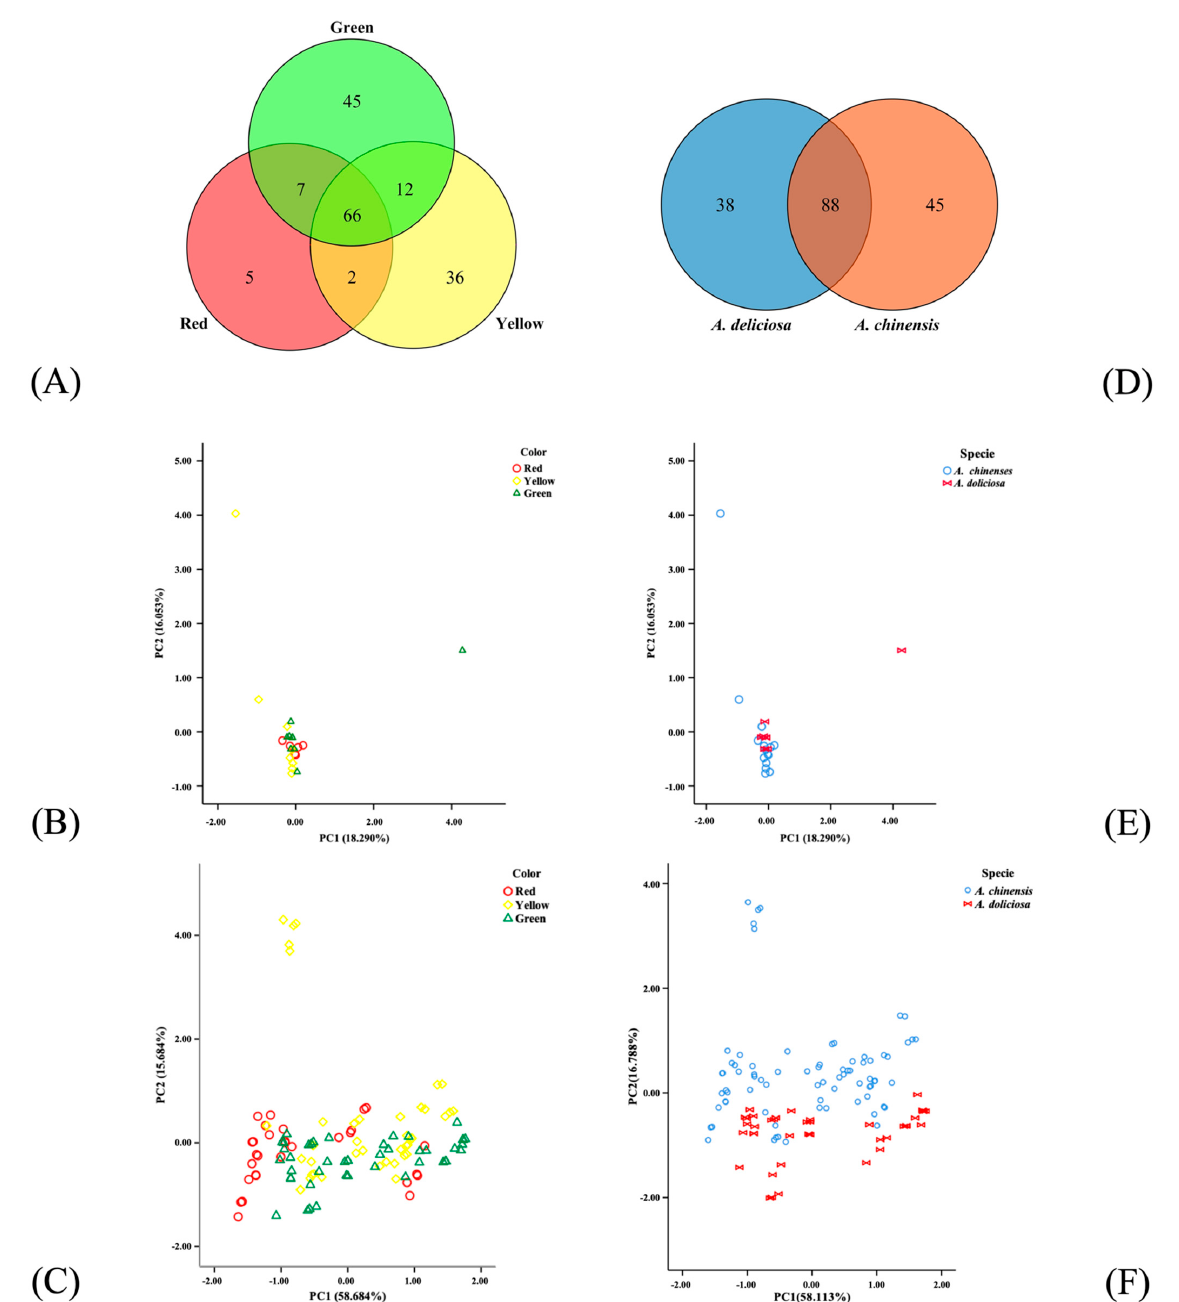
Figure 5. Venn diagrams for analysis of volatile components in kiwifruit samples with different flesh colors ( A ) and varieties ( D ). The results of PCA of kiwifruit with different flesh colors based on GC-MS data ( B ) and E-nose response data ( C ). The results of PCA of kiwifruit of different varieties based on GC-MS data ( E ) and E-nose response data ( F ).